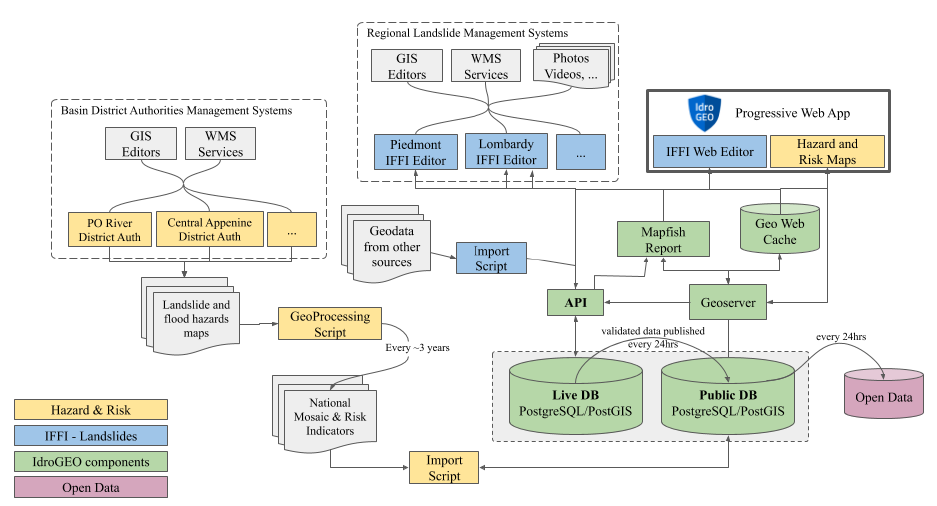
Figure 1. Information data flow of IdroGEO platform.